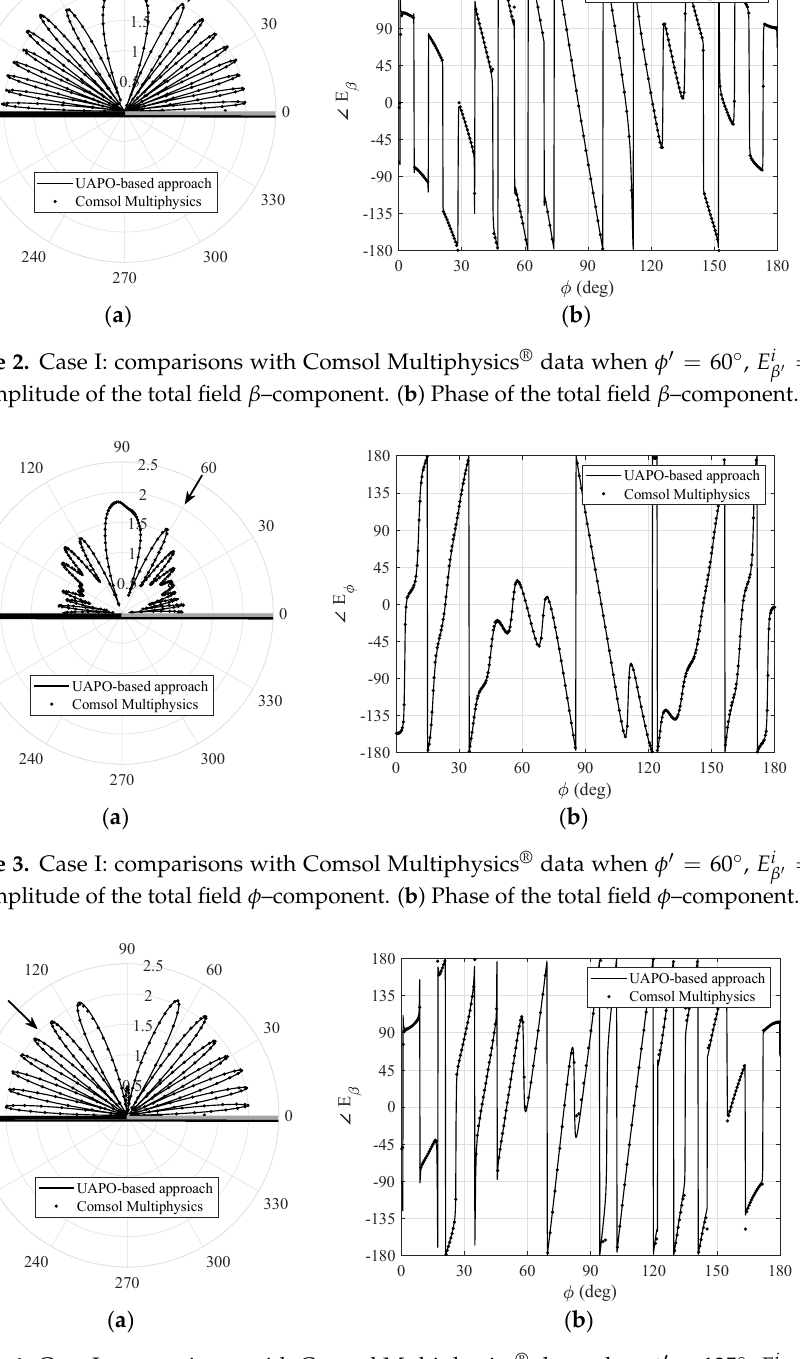
Figure 4. Case I: comparisons with Comsol Multiphysics ® data when φ (cid:48) = 135 ◦ , E i ( a ) Amplitude of the total field β –component. ( b ) Phase of the total field β –component.